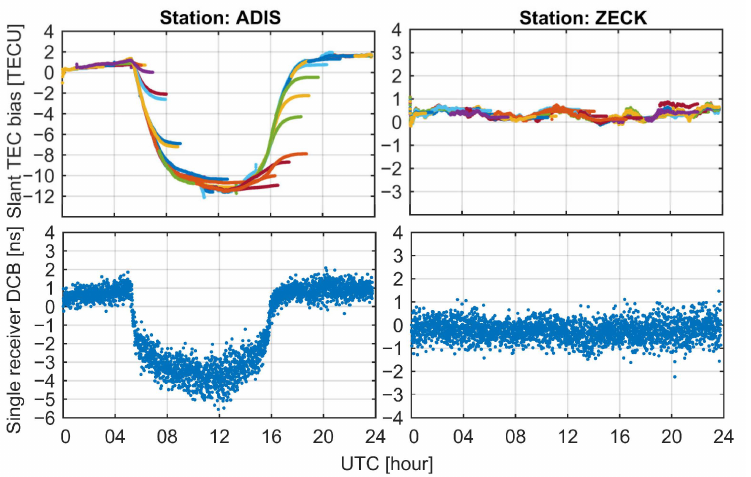
Figure 13. Biases of the ionospheric STEC (upper panels, where different colors correspond to different satellite arcs) stemming from the intraday variations in the receiver DCBs (bottom panels) for stations ADIS and ZECK on DOY 16,